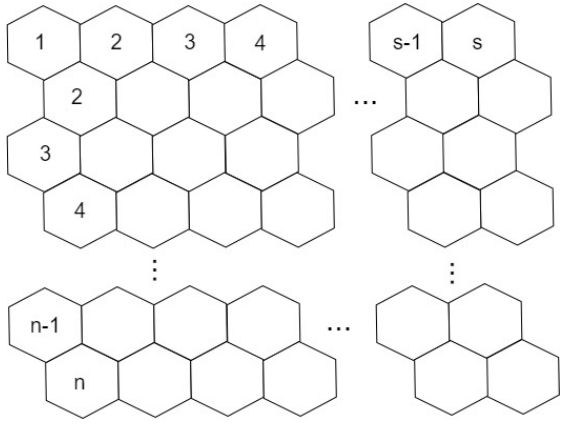
Figure 8. 2D graphene structure with ‘ n ’ rows and ‘ s ’ benzene rings in each